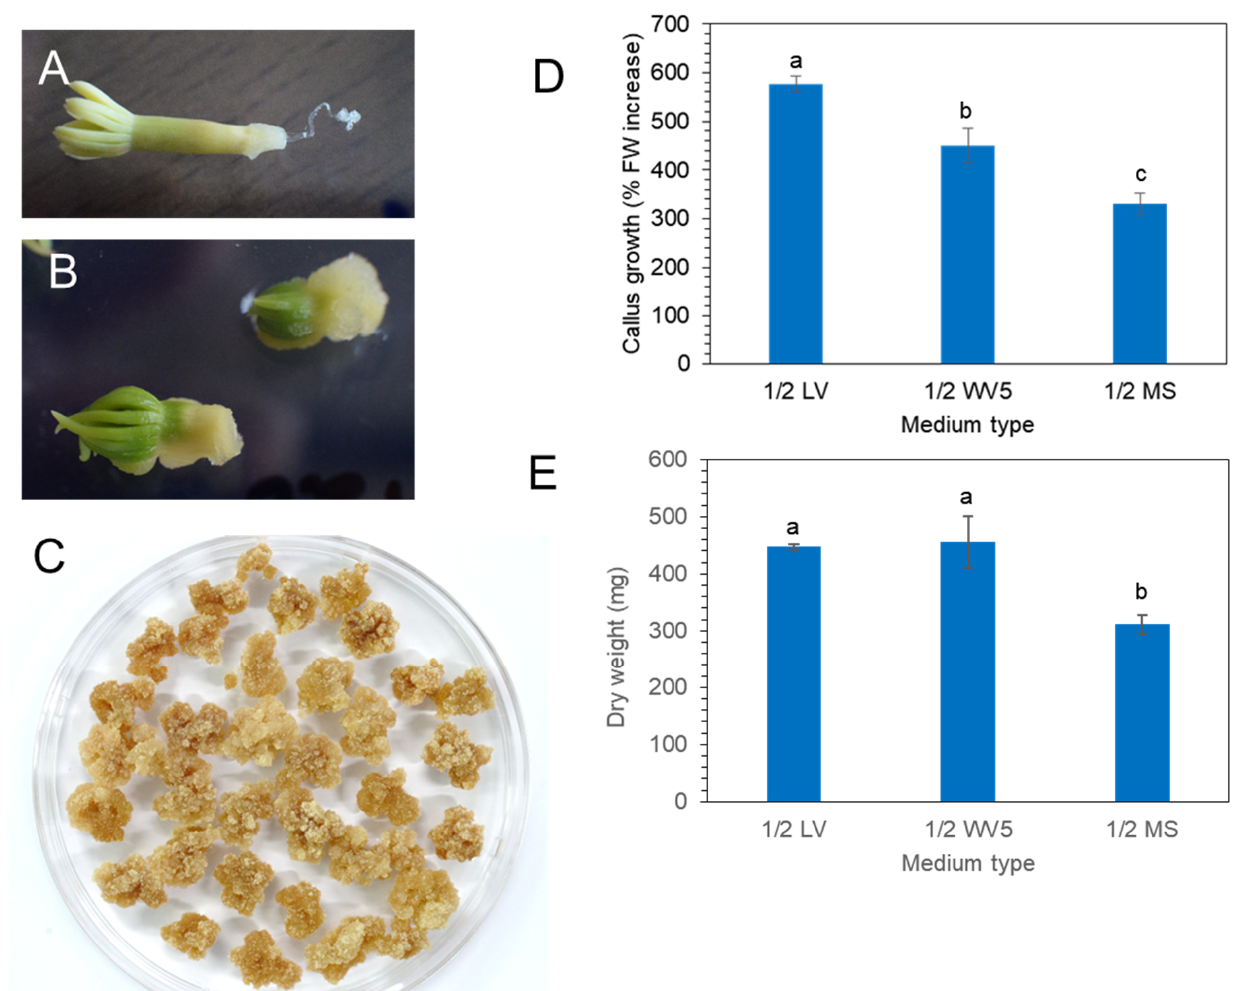
Figure 2. Callus induction and proliferation from mature zygotic embryos on three different media with 4.4 µM 2,4-D and 2.2 µM BA. ( A ) Mature zygotic embryos of P. koraiensis. ( B ). Callus induction on radicle portion of zygotic embryos after two weeks. ( C ) Proliferated calli after consecutive subculture on new 1/2 LV medium with 4.4 µM 2,4-D and 2.2 µM BA. ( D ) Fresh weight of calli on different media (1/2 LV, 1.2 WV5, and 1/2 MS) with 4.4 µM 2,4-D and 2.2 µM BA after 3 weeks of culture. ( E ) Dry weight of calli on different media (1/2 LV, 1.2 WV5, and 1/2 MS) with 4.4 µM 2,4-D